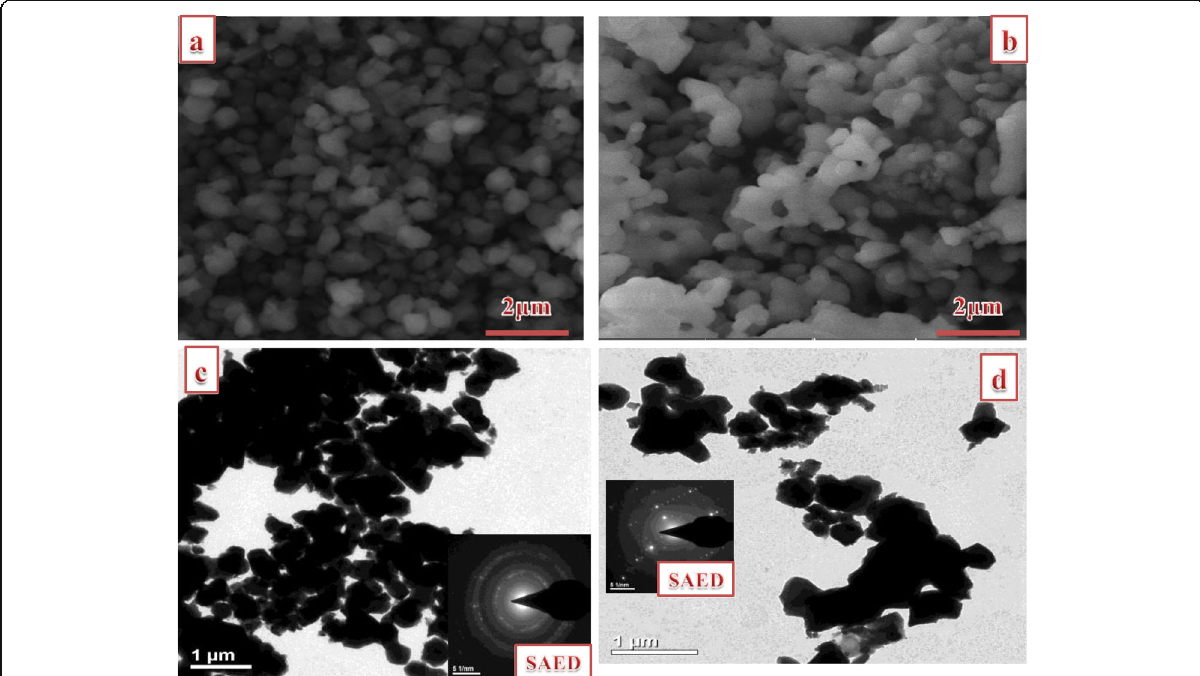
Fig. 3 SEM and TEM images of BMDA before sorption and after pollutants